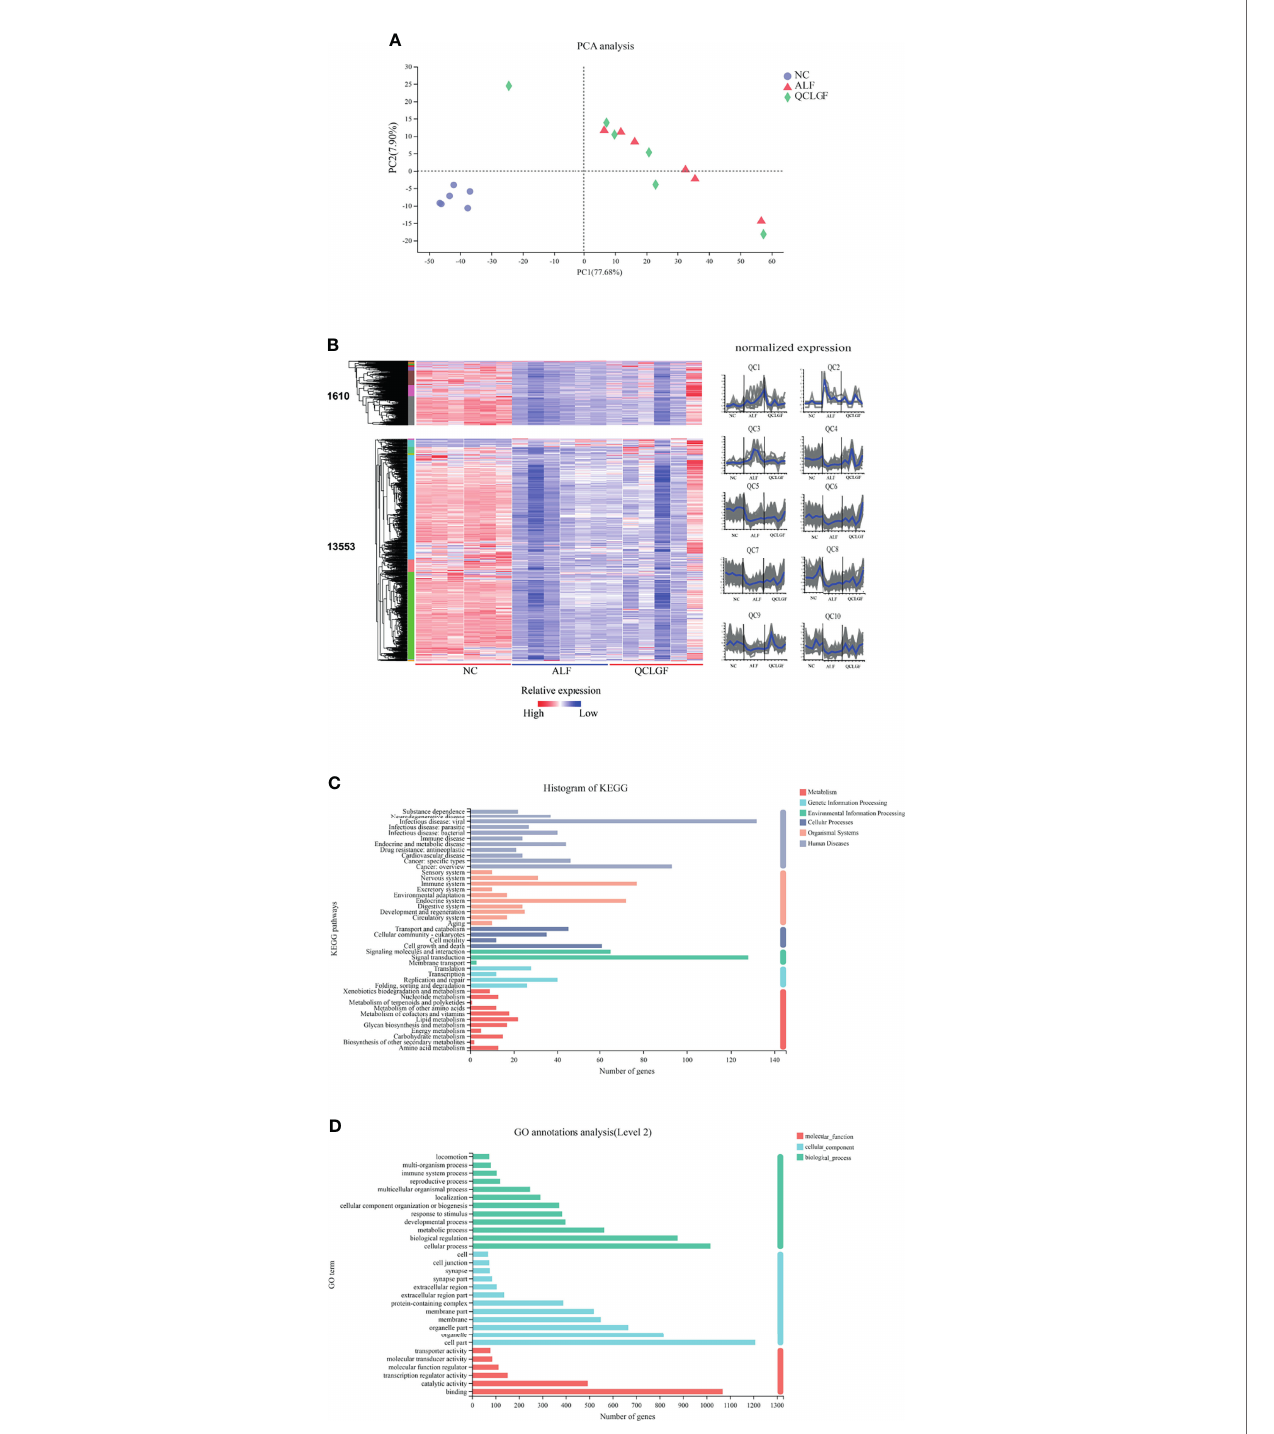
FIGURE 4 | Comparisons of gene expression pro fi les in the rat liver by RNA-seq among different treatment groups. (A) Principal component analysis showed that the NC group had distinct gene expression signatures compared with the ALF rats and QCLGF rats PC1 (explaining 77.68% of variation). (B) Heatmap of DEGs. Compared with the NC group, the number of differentially expressed genes (DEGs) in the ALF groups was 13553 (DEG1, 529/13024; upregulated and downregulated DEGs, DEGseq, respectively). Genes of QCLGF vs. ALF and NC vs. ALF with the same trend were 1610 (DEG3, 1581/29; upregulated and downregulated DEGs, DEGseq, respectively), DEG3 genes were further clustered into 10 QCLGF clusters (QCs) according to their expression pro fi les. (C) KEGG annotation of DEG3. (D) GO annotation analysis of